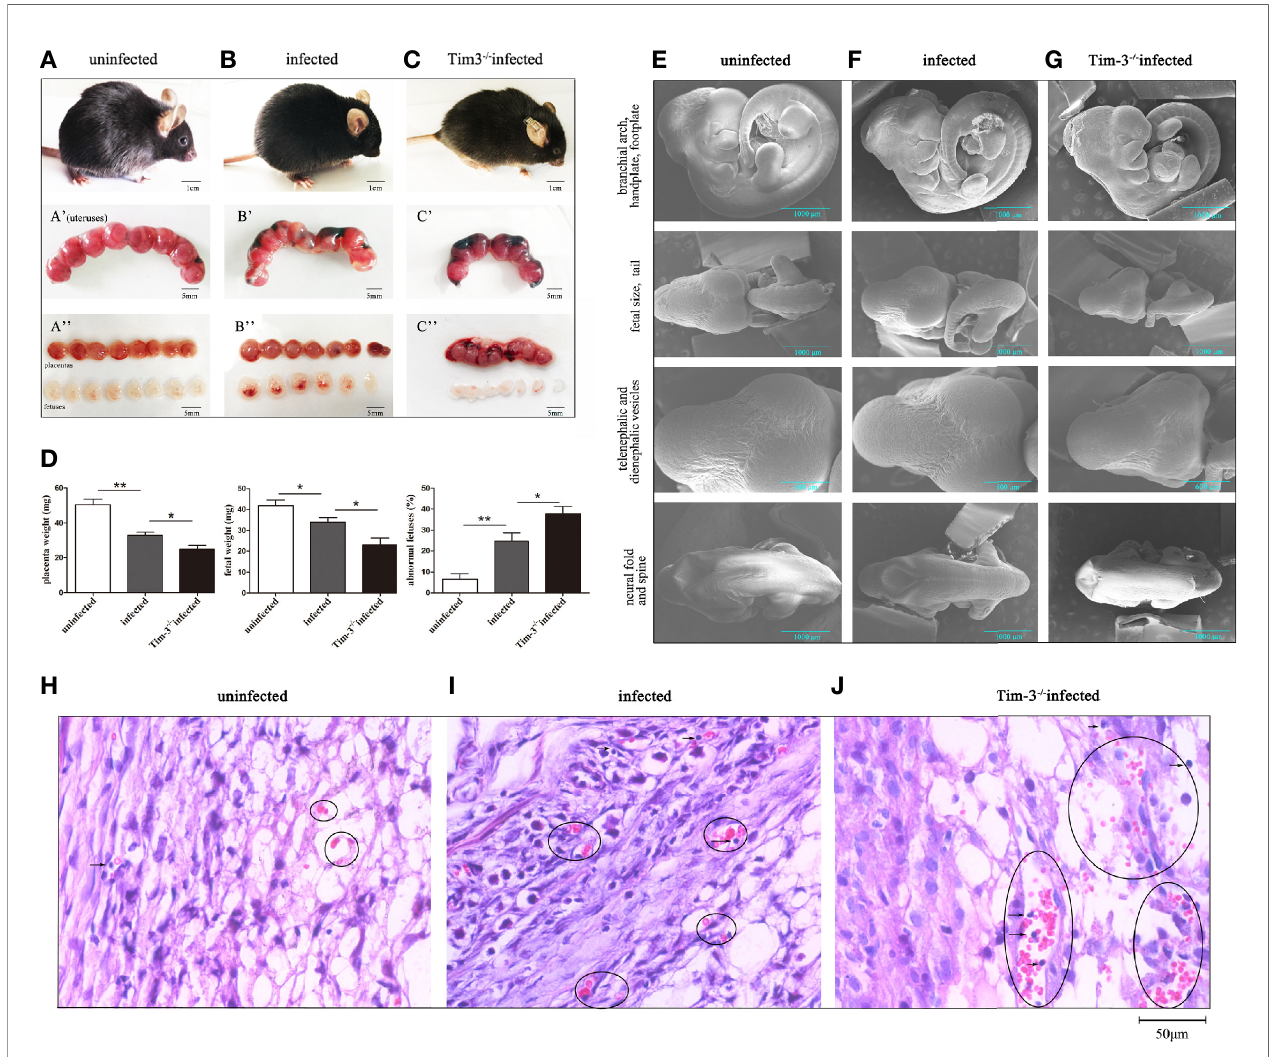
FIGURE 1 | The impact of Tim-3 on adverse pregnancy outcomes caused by T. gondii infection in mice. (A) Uninfected pregnant mice were in good condition, the placentas and fetuses developed normally. (B) T. gondii infected pregnant mice exhibited spiritual malaise, with in fl ammatory hyperemia of placentas and fetuses. (C) T. gondii infected Tim-3 -/- pregnant mice had sluggish responses, their fetuses were smaller and shapeless. Scale bar of A, B, C was 1 cm. Scale bar of A ’ , A ’’ , B ’ , B ’’ , C ’ and C ’’ were 5 mm. (D) The weights of placentas and fetuses, and fetal abnormalities rates were calculated in uninfected, infected, Tim-3 -/- infected mice. The abnormal fetuses included stillbirths and resorption sites. The rates of abnormal fetus were calculated as the ratio of stillbirths and resorption sites to the total number of implantation sites. (Data are presented as means ± SD. N=10 mice per group, * p < 0.05, ** p < 0.01, by the unpaired t -test). (E) Scanning electron microscopy images of fetuses from uninfected mice, the fetuses were healthy and well developed. (F) Fetuses of infected mice exhibited delayed hand-plates and foot-plates development. (G) Fetuses of infected Tim-3 -/- mice displayed obvious intrauterine growth restriction in head, body size, hand-plates and foot-plates development. Scale bar, 1000µm and 600µm. (H-J) Hematoxylin and eosin (H & E) staining of uninfected, infected and Tim-3 -/- infected mouse placentas. Obvious hemorrhaging and lymphocytes in fi ltration were showed by black circles. Scale bar,